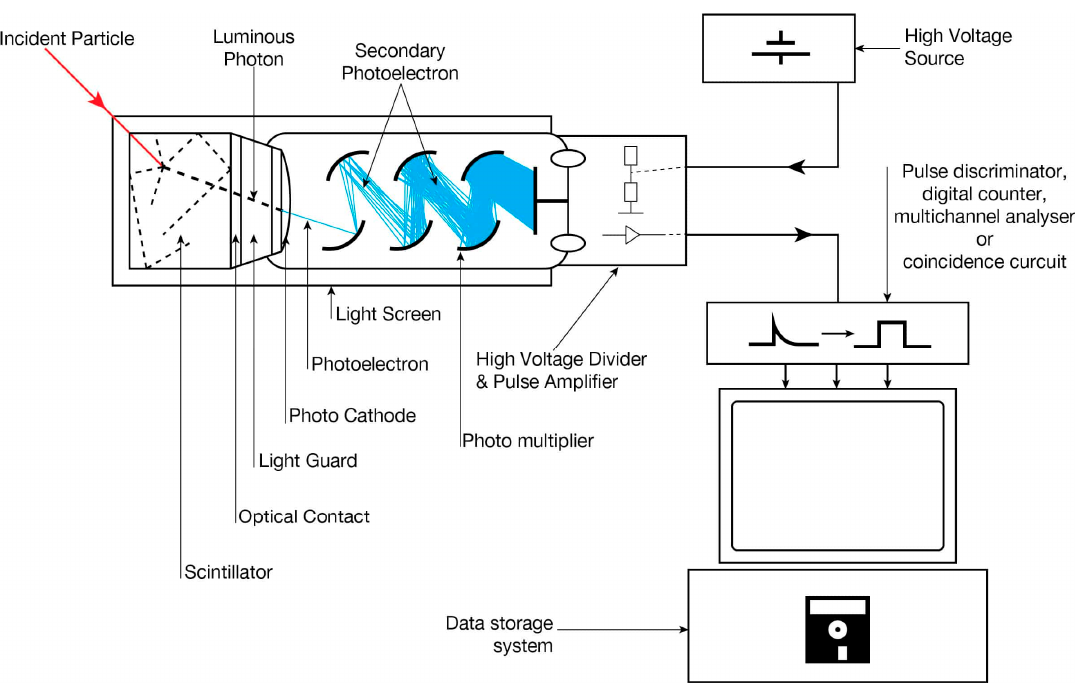
Figure 2. Schematic set-up of a Scintillation detector [3].